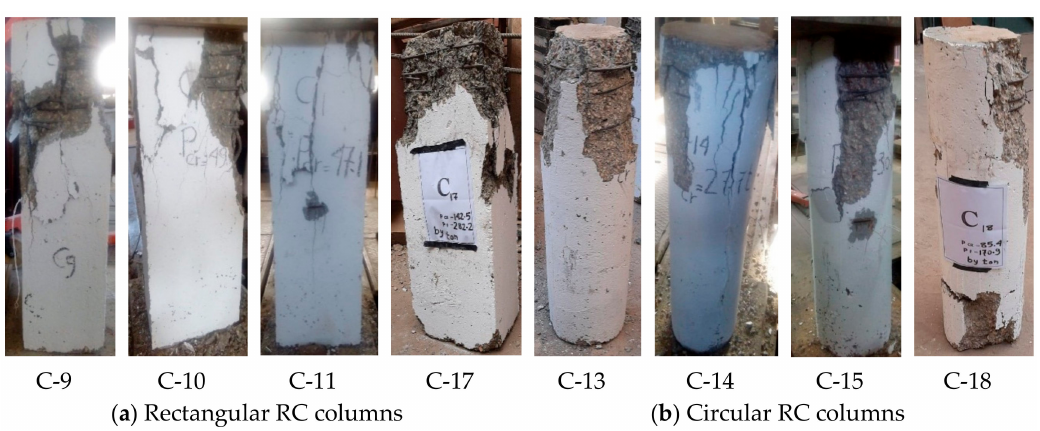
Figure 7. Crack patterns of the strengthened RC columns.